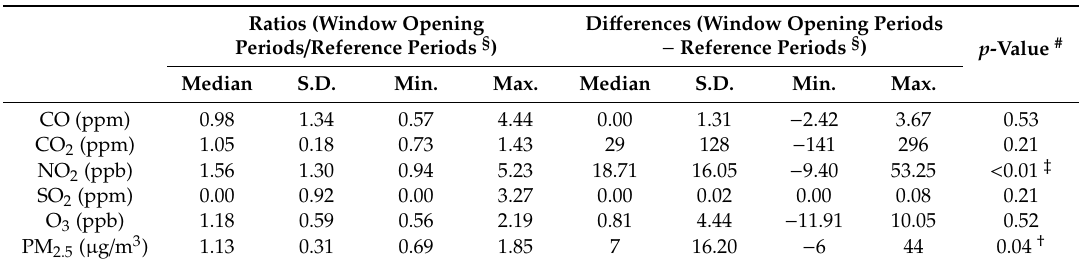
Table 3. The ratios of air pollutants during window opening periods to reference periods and the di ff erences in air pollutants between window opening periods and reference periods. Ratios (Window Opening Di ff erences (Window Opening Periods − Reference Periods § ) Periods / Reference Periods § )